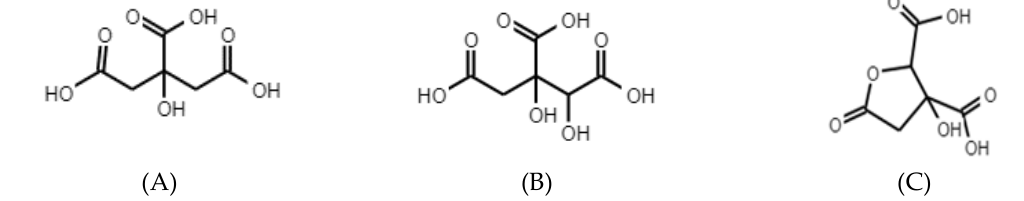
Figure 2. Chemical structure of the main organic acids of Hs. ( A ) Citric acid, ( B ) Hydroxycitric acid, and ( C ) Hibiscus acid [3,16].